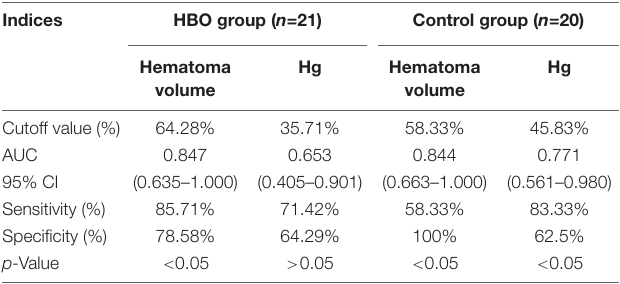
TABLE 3 | Indices of lowest relative factors for predicting good